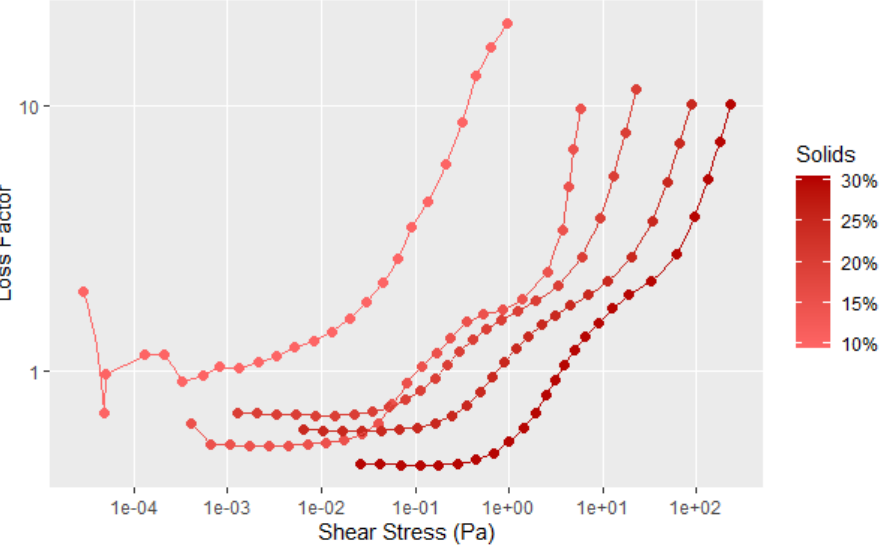
Figure 6. Loss factor data for tests shown in Figure 5, with the lines showing the average of 3 to 4 runs. 4